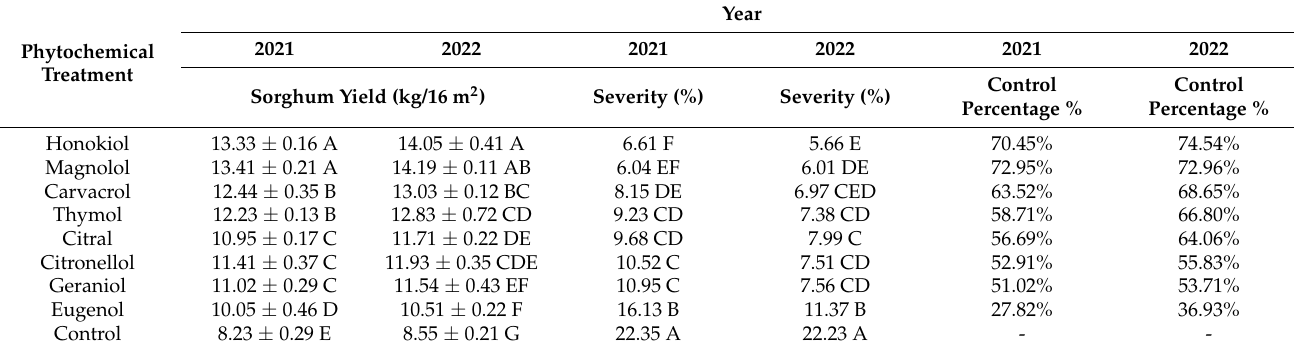
Table 4. Effects of phytochemical treatments on disease control and